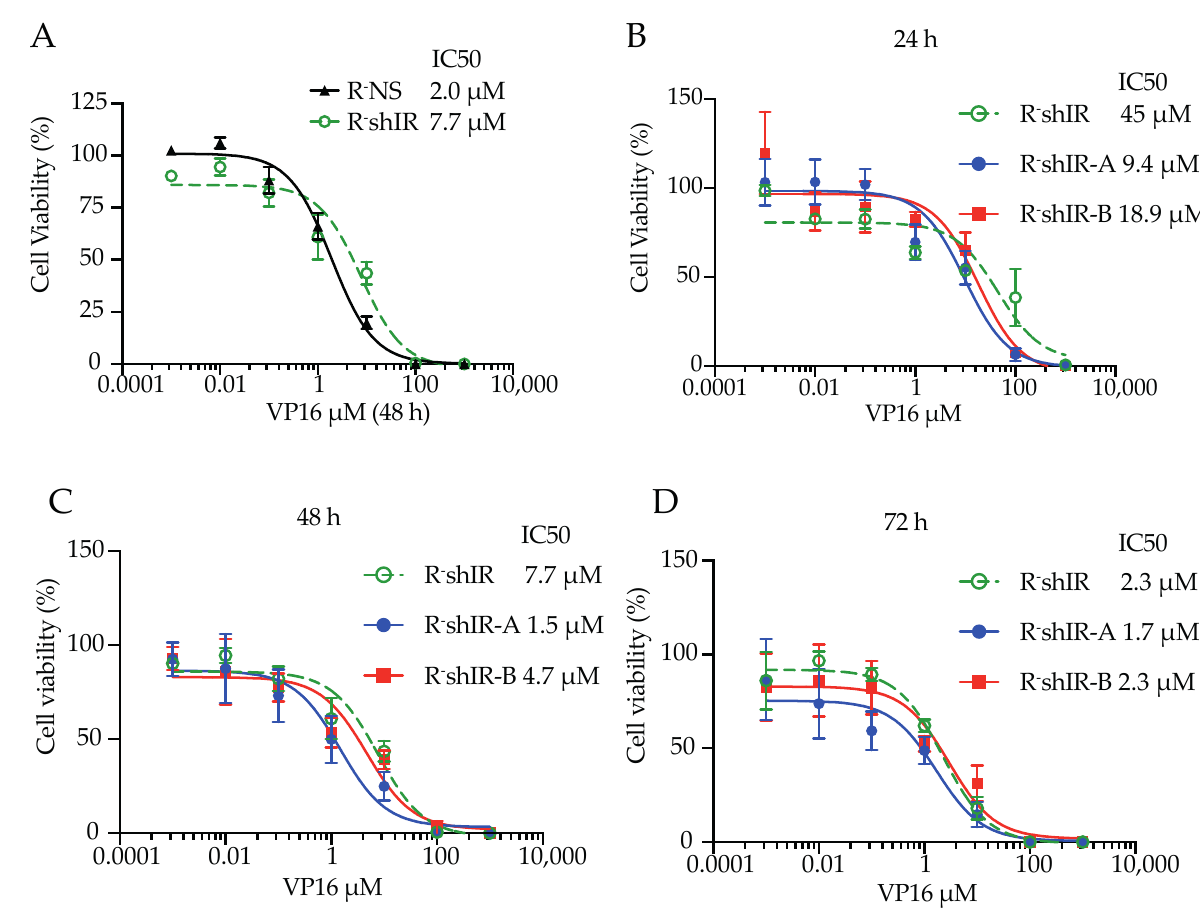
Figure 3. Insulin-unbound IR-A and IR-B differently affect cell viability after VP-16-induced DNA double-strand break. ( A – D ): The indicate cell lines, cultivated in DMEM supplemented with 10% FBS and 2 mM glutamine, were exposed to increasing logarithmic concentrations of etoposide (VP-16). Cell viability was measured with the MTS assay and data expressed setting at 100% the OD450 nm obtained from untreated cells. VP-16 half-maximal inhibitory concentration